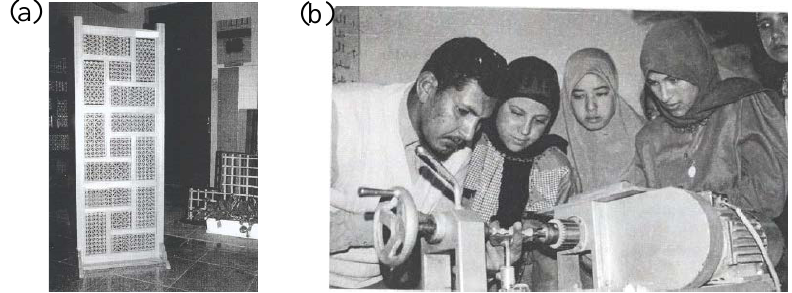
Figure 8. Photographs of (a) apartition of the Arabesque (b)Training beneficiaries on Arabesquehandicrafts. [Source: El-Mously, H.I.Centre For Development of Small-Scale Industries]